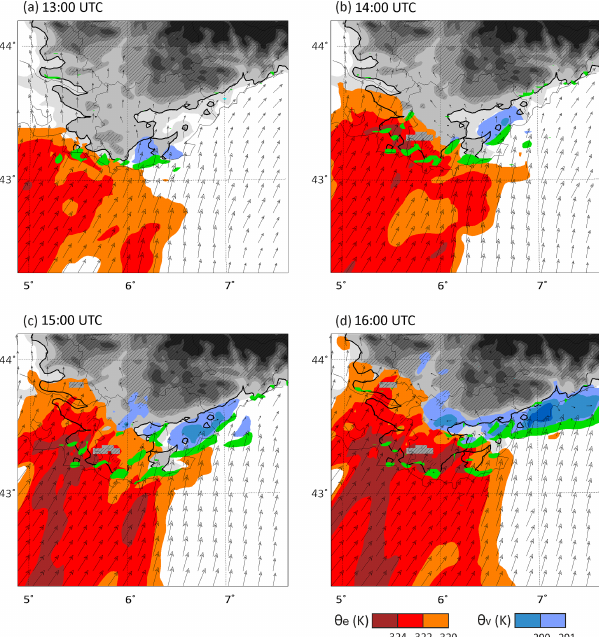
Figure 3. Radar reflectivity (dBZ) and horizontal winds simulated in CNTL at 2000ma.s.l. at (a) 13:00, (b) 14:00, (c) 15:00, and (d) 16:00UTC on 14 October 2012.